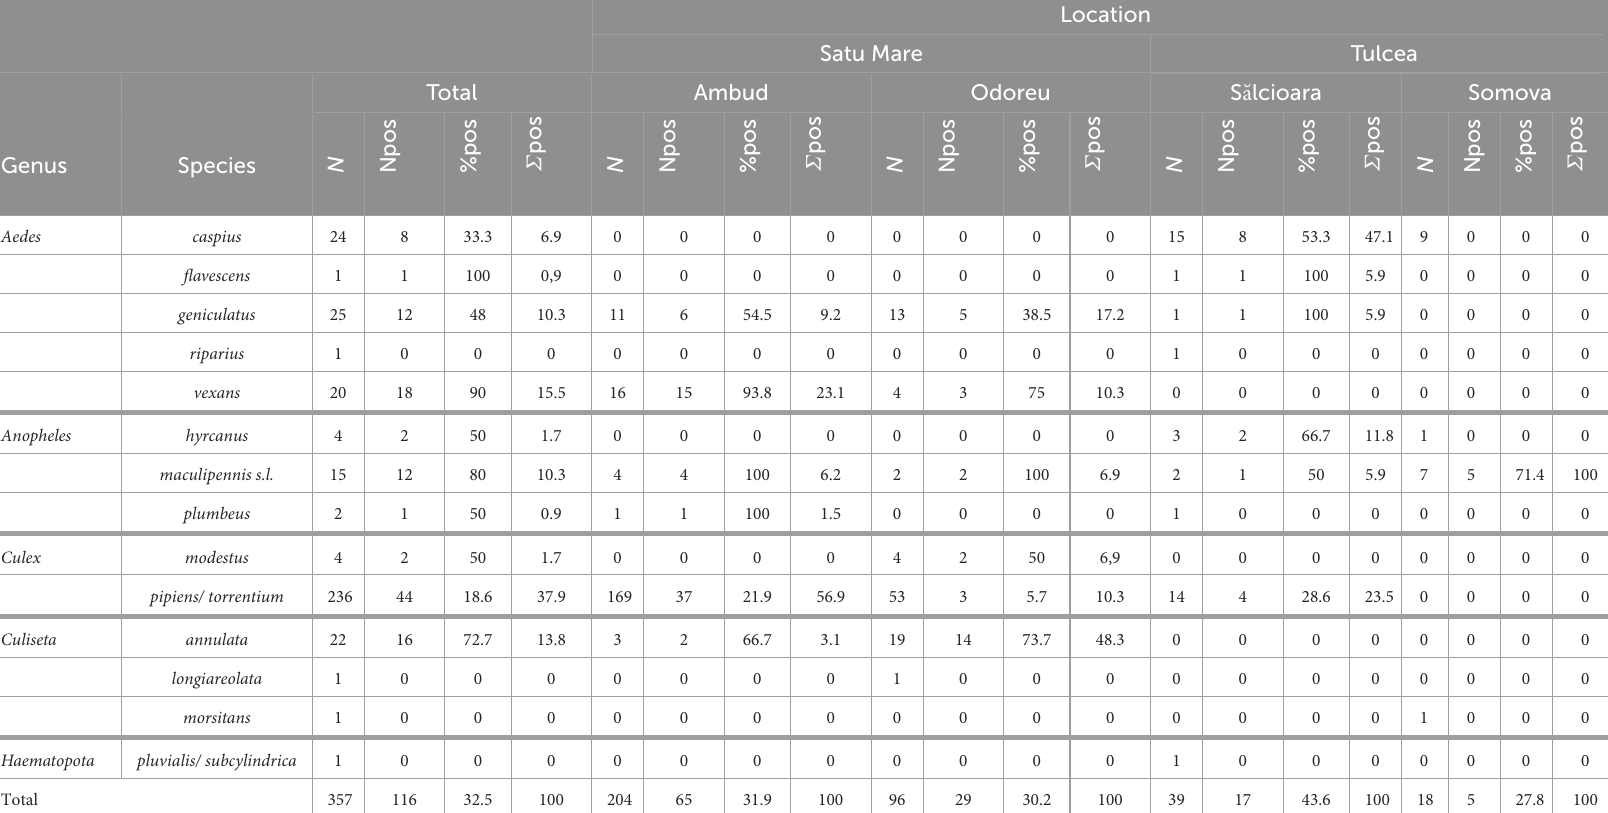
TABLE 1 Overview of the number of mosquitoes and horseflies ( N ) caught in the pig cages of each species in total and per location, as well as the number (Npos) and percentage (%pos) of porcine-blood PCR positive samples per